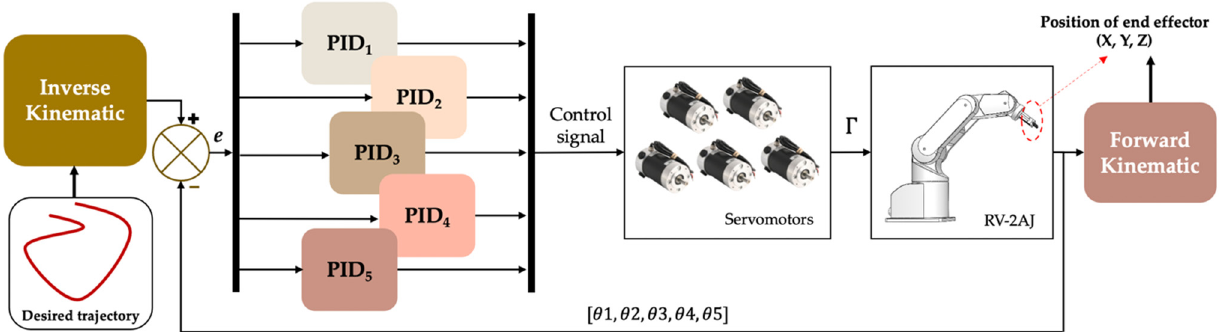
Figure 8. PID closed loop control of RV-2AJ robot arm.